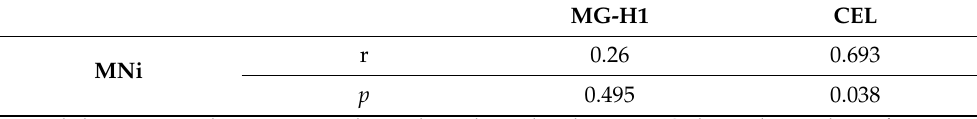
Table 1. Pearson correlations for relationships between AGE biomarkers and